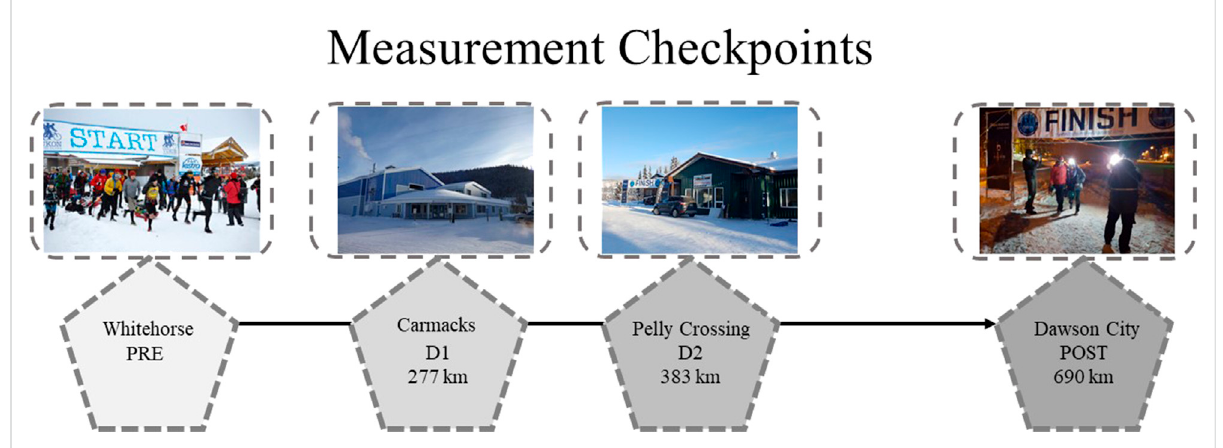
FIGURE 3 The measurement checkpoints: before the race in Whitehorse (PRE), during the race in Carmacks at 277 km (D1), and Pelly Crossing at 383 km (D2), after the race in Dawson City at 690 km